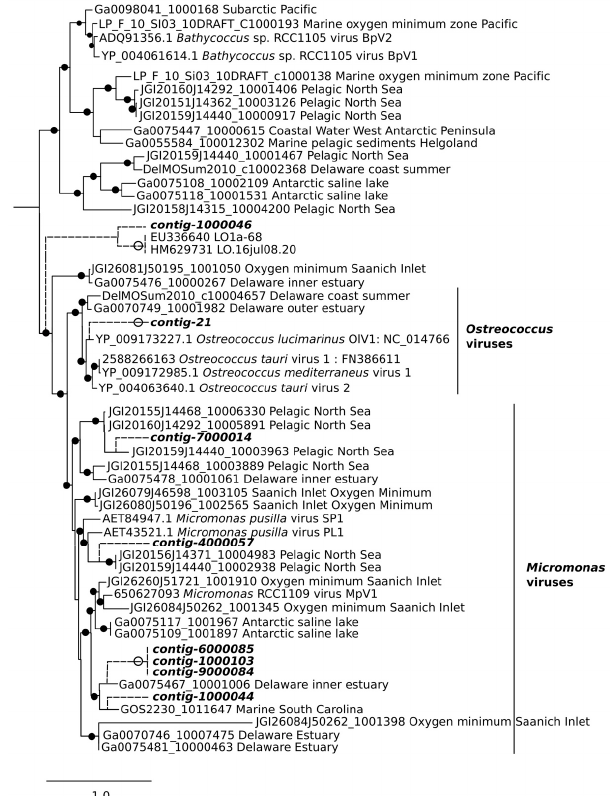
Figure 6. Evolutionary Placement Algorithm (EPA) of the prasinovirus DNA Pol contigs, which contributed most to the dissimilarity between freshwater and brackish/saltwater samples in Similarity Percentage (SIMPER) analysis. Closed circles show nodes of the reference tree with bootstrap values >50 (out of 100). Open circles show contigs placed by EPA with Likelihood Weight >0.5. Scale bar shows number of substitutions. Branch lengths to contigs (broken lines) are arbitrary.